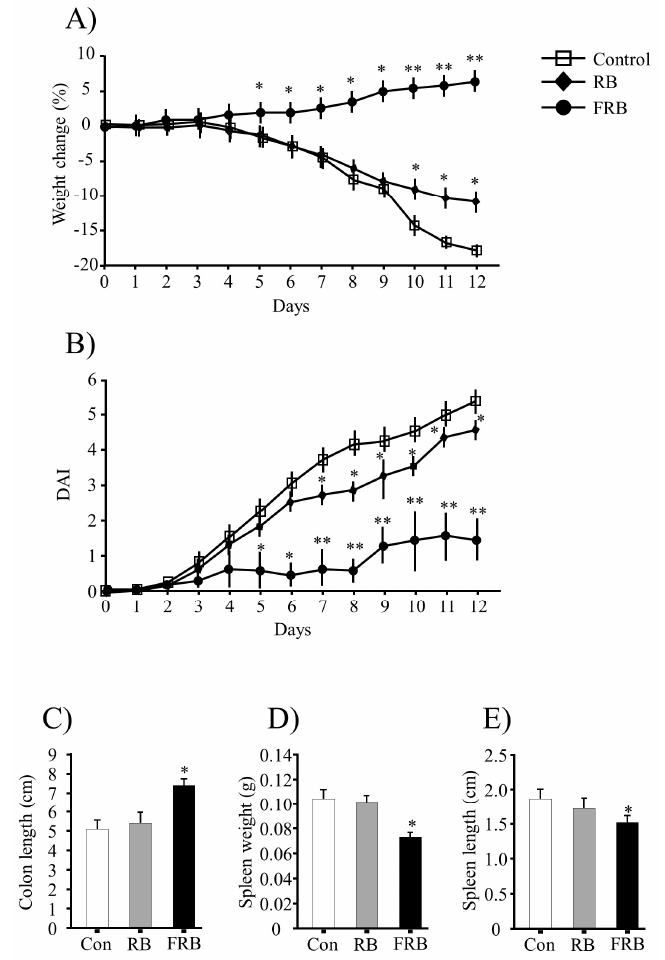
Figure 1. General evaluation of colitis. ( A ) Body weight change (%); ( B ) disease activity index (DAI); ( C ) colon length; ( D ) spleen weight; and ( E ) spleen length determination. Body weight loss was calculated as the percent difference between the original body weight (day 0) and the body weight on any particular day. The DAI was calculated based on the diarrheal score (0, normal; 1, mild soft; 2, very soft; and 3, watery stool) and the presence or absence of fecal blood (0, normal; 2, brown; 3, reddish; and 4, bloody stool). The values are expressed as the mean ± SEM ( n = 8); one-way ANOVA was done FRB, fermented rice